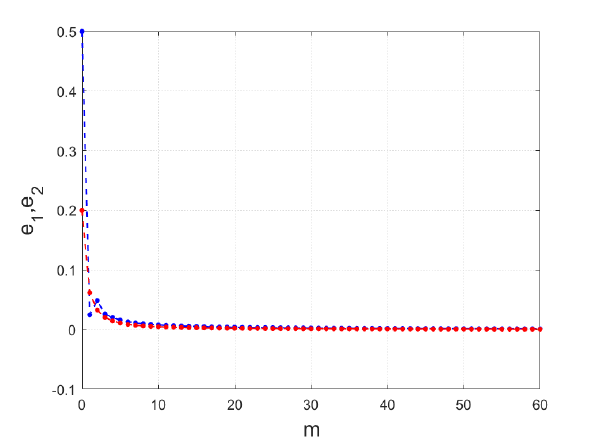
Figure 11. Time evolution of the fractional error system (23) ( e 1 (blue) and e 2